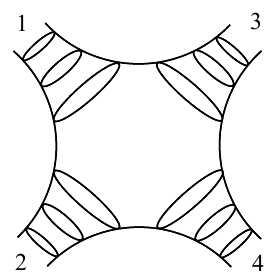
Figure 12. A contribution to the eight-point function. This was included in both lines shown before in (cid:12)gure 9, and so must be subtracted due to double